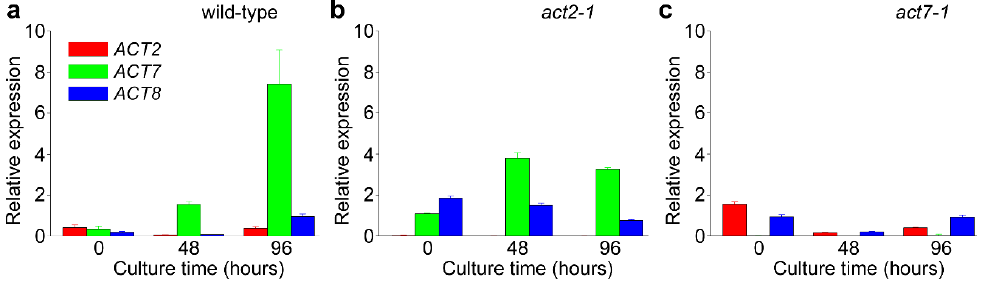
Figure 4. Changes in relative expression of ACT2 , ACT7, and ACT8 across culture of protoplasts derived from ( a ) wild-type and ( b ) act2-1 and ( c ) act7-1 mutants. Data is mean ± SE, n = 3